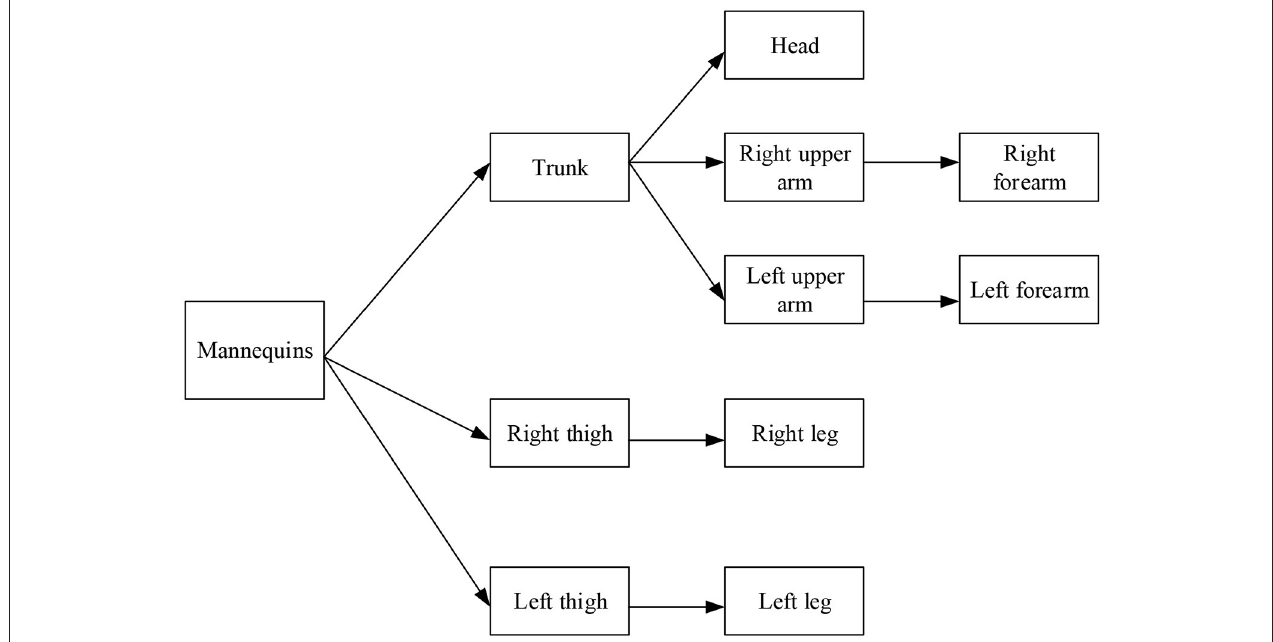
FIGURE 5 | The model of the human